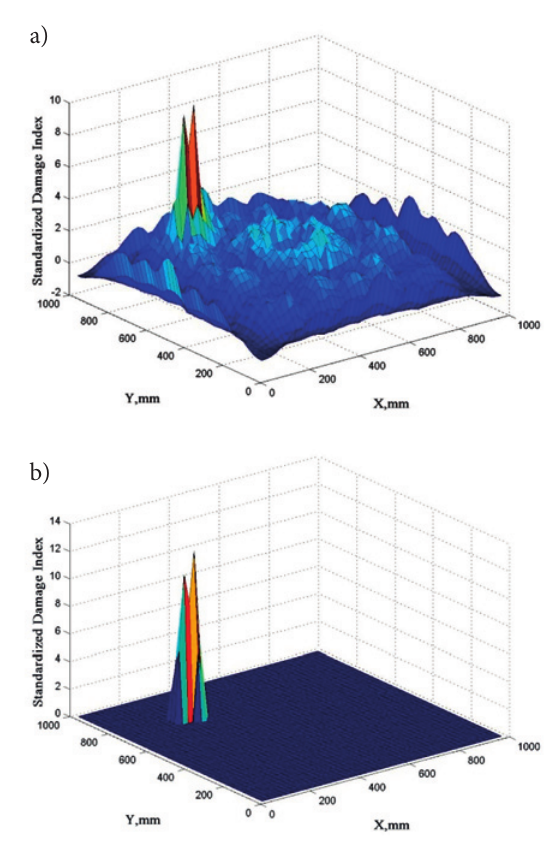
fig. 5. Standardized MSCS damage index for test case 1.3: (a) before truncation and (b) after